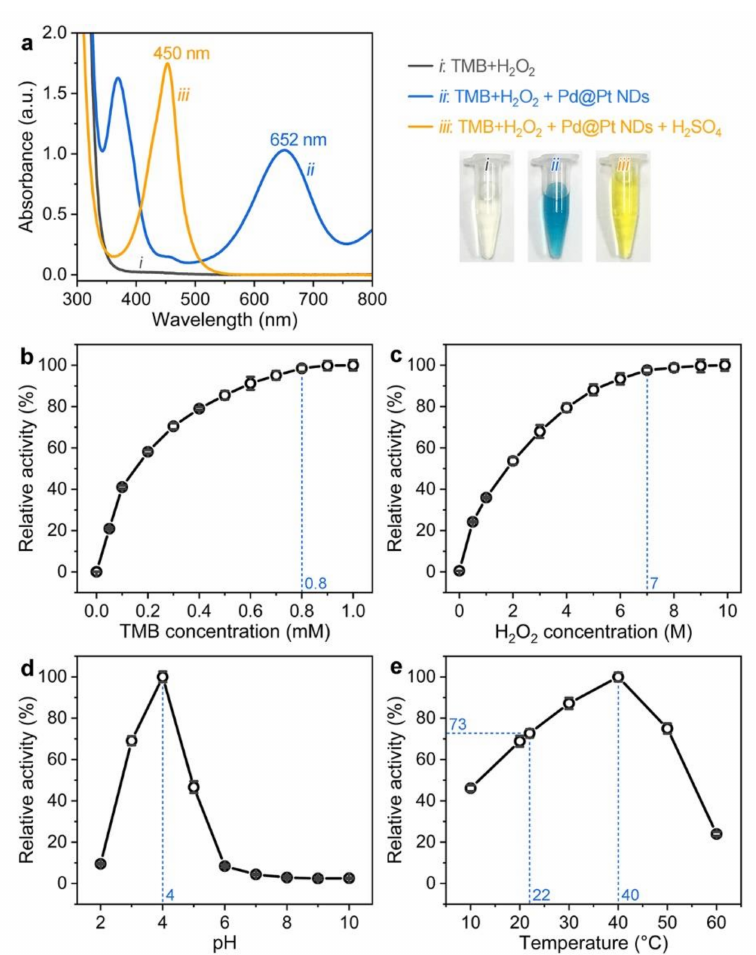
Figure 2. Verification and optimization of the peroxidase-like catalytic activity of Pd@Pt NDs. ( a ) UV-vis spectra of TMB+H 2 O 2 substrate solution (i), (TMB+H 2 O 2 )+Pd@Pt NDs solution (ii), and (TMB + H 2 O 2 )+Pd@Pt NDs + H 2 SO 4 solution (iii). The bottom-right panel shows the